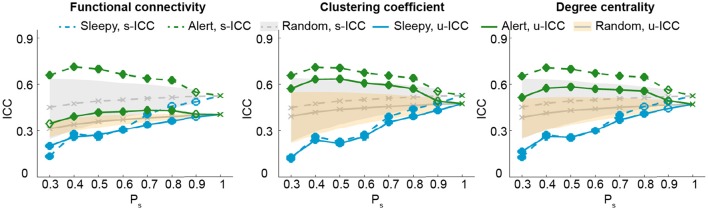
Test-retest reliability analysis using a serial of volume selection percentiles (Ps), based on RMSSD. The shades indicate the distribution of the ICCs derived from random condition—upper and lower bounds marking the 95 and 5 percentiles, respectively. Values outside the shades are significantly different from the random conditions, and represented using solid markers (one-tailed permutation test, p < 0.05). Results of clustering coefficient and degree centrality were obtained from Tr = 0.1.